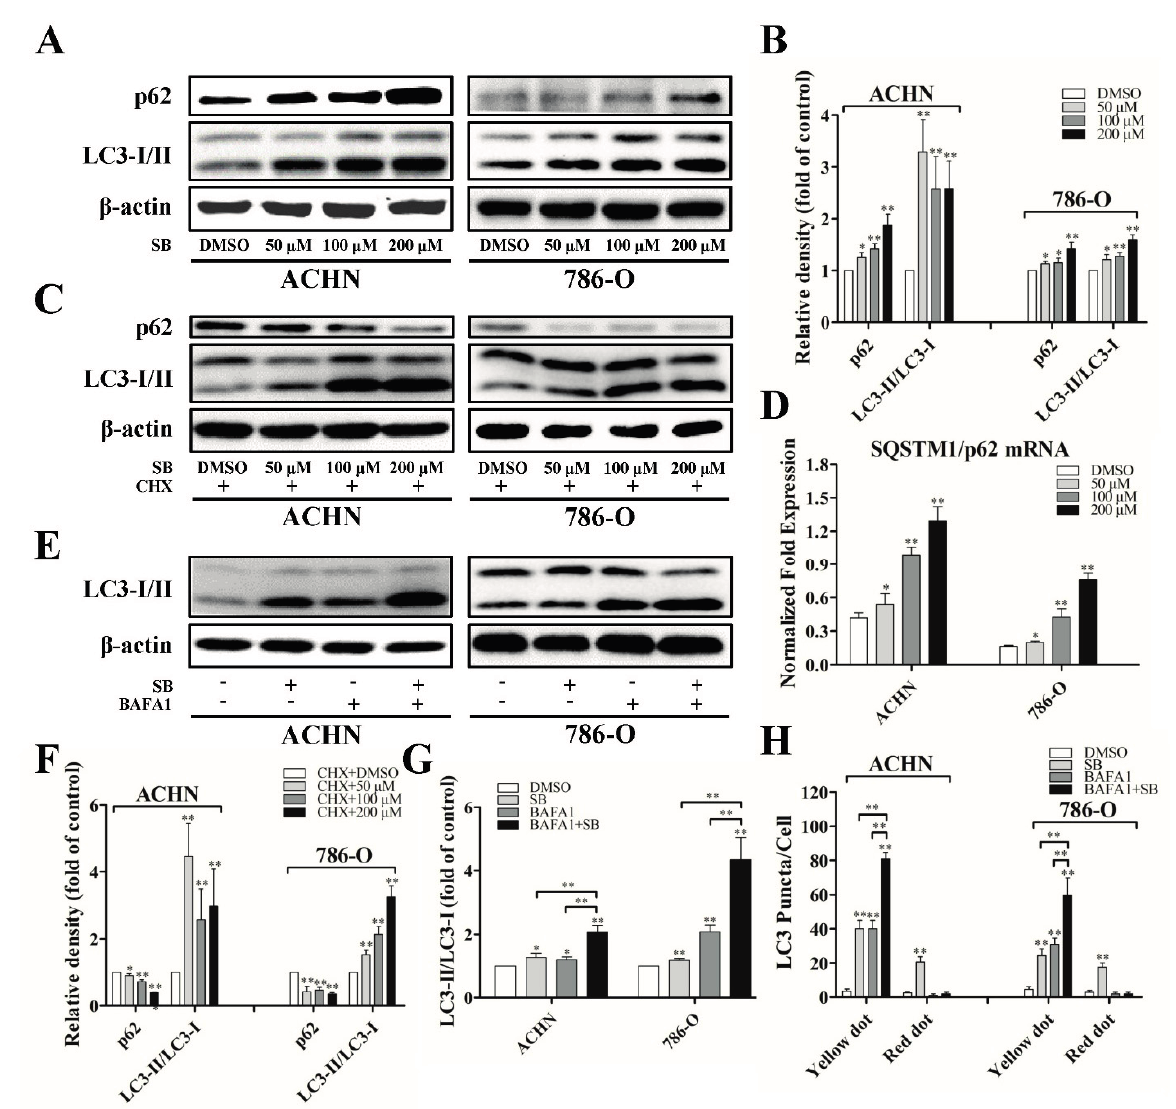
Figure 2. Silibinin induces autophagic flux in RCC ACHN and 786-O cells. ( A ) Cells were treated with indicated dose of silibinin (SB) for 24 h, the levels of p62 and LC3-I/II were checked by Western blot and quantitative analyses were done ( B ); ( C , F ) RCC cells were treated with the indicated dose of silibinin for 24 h in the presence and absence of 350 nM cyclohexamide and the levels of p62 and LC3-I/II were examined; ( D ) The expression of SQSTM1/p62 mRNA accessed by real-time PCR. RCC cells were treated with 50 μ M of silibinin for 24 h in the presence and absence of 10 nM BAFA1 and the levels of LC3-I/II ( E , G ) and the numbers of LC3 puncta ( H ) were examined. Blots are representative of three separate experiments. Error bars represent SDs. * p < 0.05; ** p <